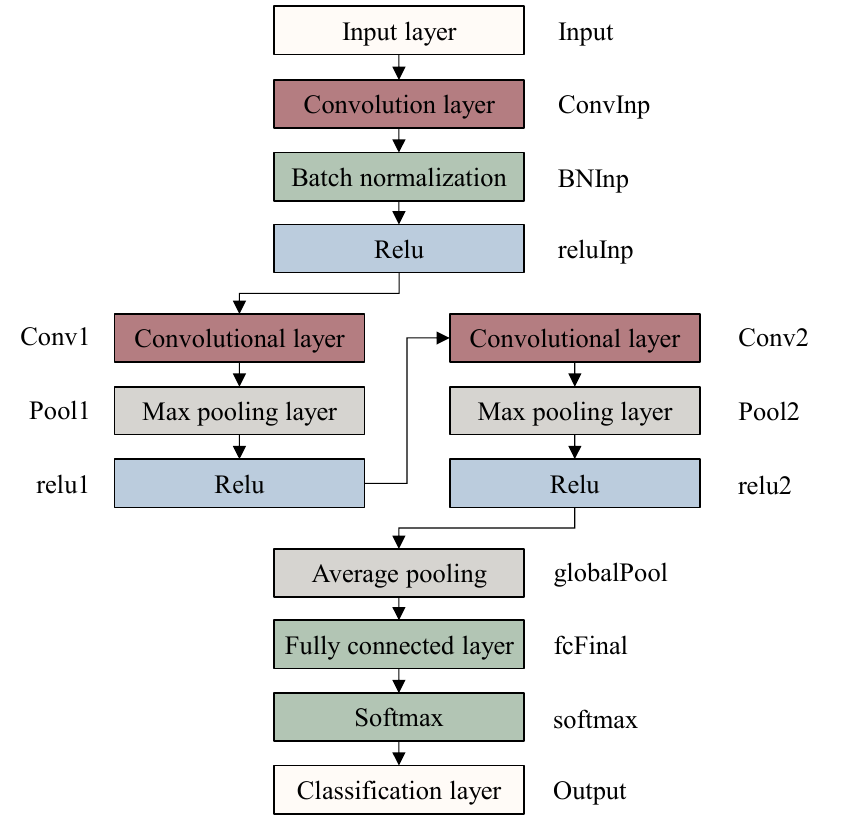
Figure 12. The CNN layer graph.